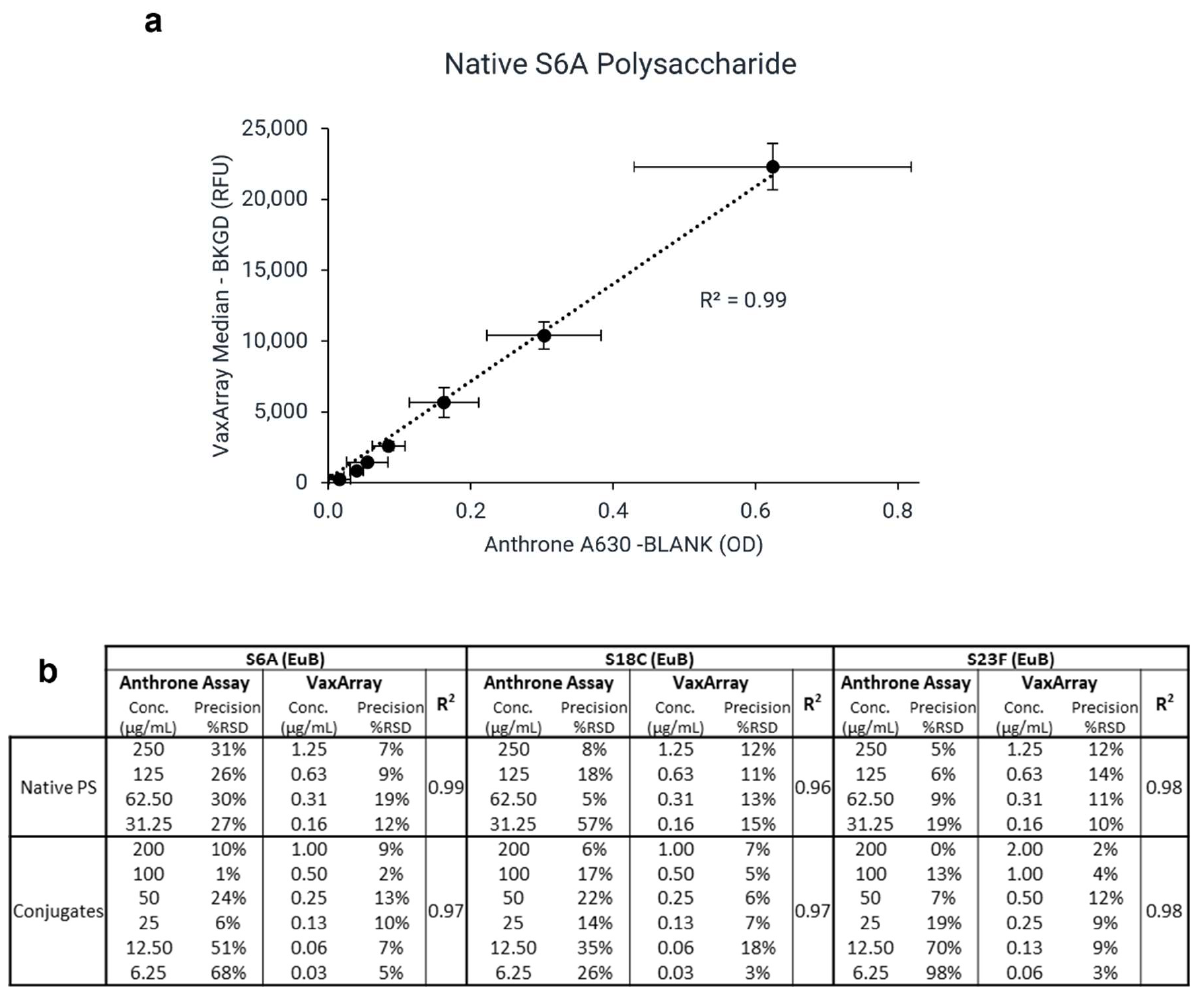
Figure 5. Signal correlation between anthrone and VaxArray assays. ( a ) Signal response correlation for S6A native PS from EuBiologics (EuB). The same serial dilution evaluated by the anthrone assay was diluted 100- to 200-fold to perform VaxArray assay due to VaxArray assay sensitivity. Error bars indicate ± 1 standard deviation (n = 3). ( b ) Precision (%RSD) for anthrone and VaxArray assays and associated R2 value for signal correlation of each sample (n = 3 for each concentration of each method).